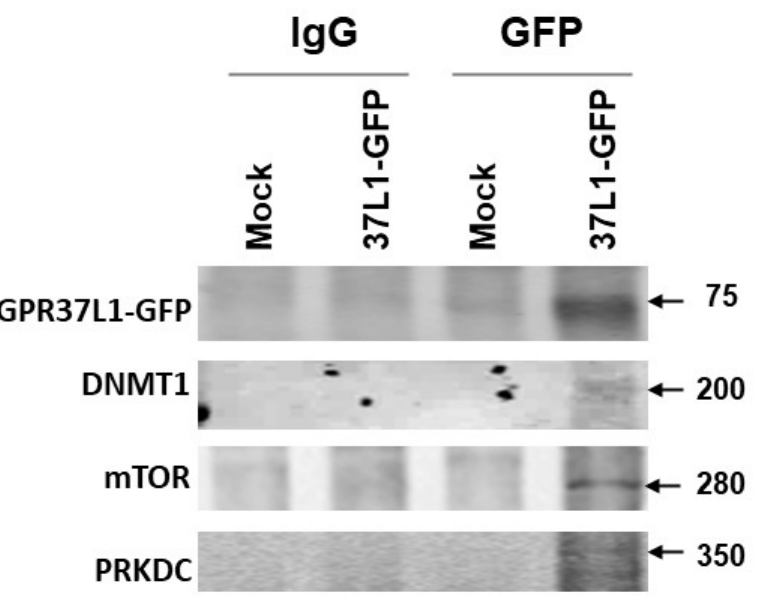
Figure 6. GPR37L1 interacts with DNMT1, mTOR, and PRKDC . The glycerol gradient fractions 10–14 of the protein preparation from hRPTCs expressing GPR37L1-GFP (37L1-GFP) or the mock- transfected hRPTCs (mock) from (Figure 1) were used for Co-IP using the GFP antibody (GFP) or control rabbit IgG (IgG). The Co-IP samples were immunoblotted to detect GPR37L1-GFP, DNMT1, mTOR, or PRKDC. The molecular size markers are indicated on the right.